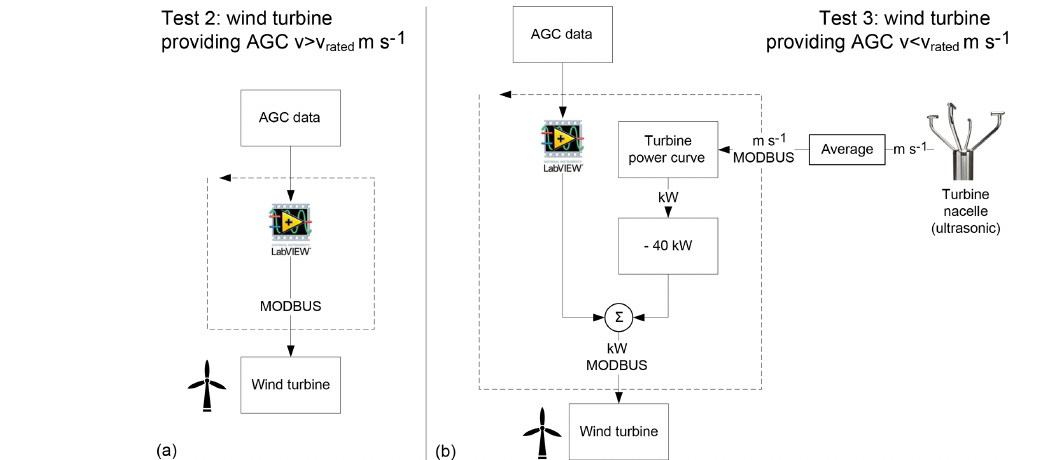
Figure 6. Algorithms for (a) Test 2 and (b) Test 3.